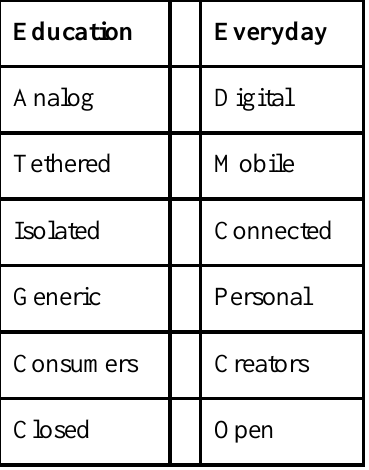
The Differences between Higher Education and the Supersystem in which it is Embedded